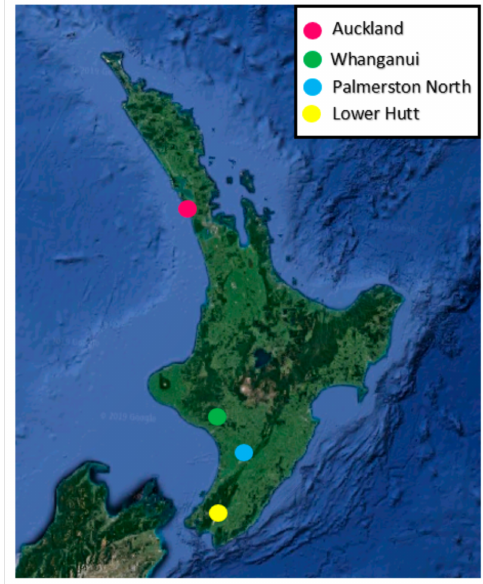
Figure 2. Sampling locations of Clitarchus hookeri , in the North Island, New Zealand.